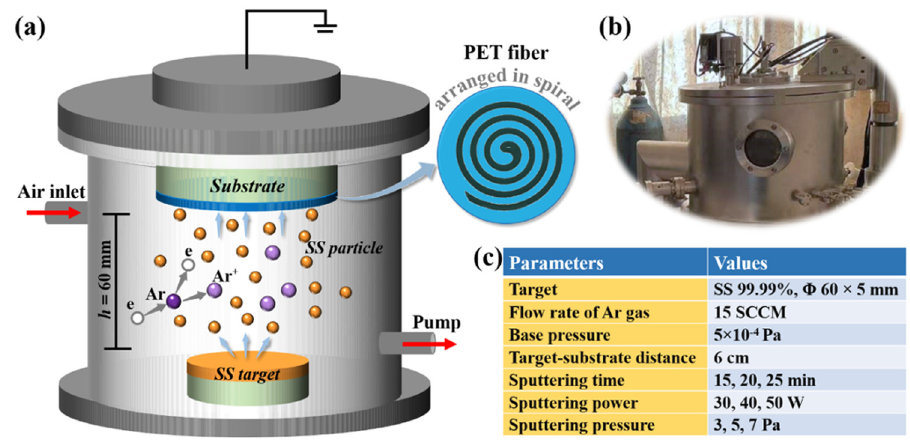
Figure 1: ( a ) Schematic and ( b ) the experimental setup of the preparation of SS - sputtered PET fi ber; ( c ) the detailed deposition